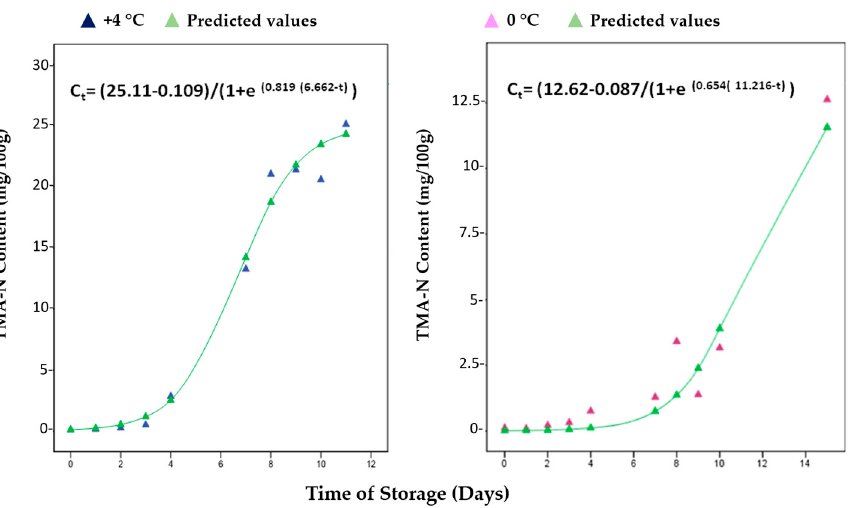
Figure 3. Fitted models of TMA-N concentrations (mg/100 g) for red mullets ( Mullus barbatus ) during the storage at both +4 ◦ C and 0 ◦ C. All the concentrations were calculated via NMR by using the protocol fine-tuned by Ciampa et al. [8].